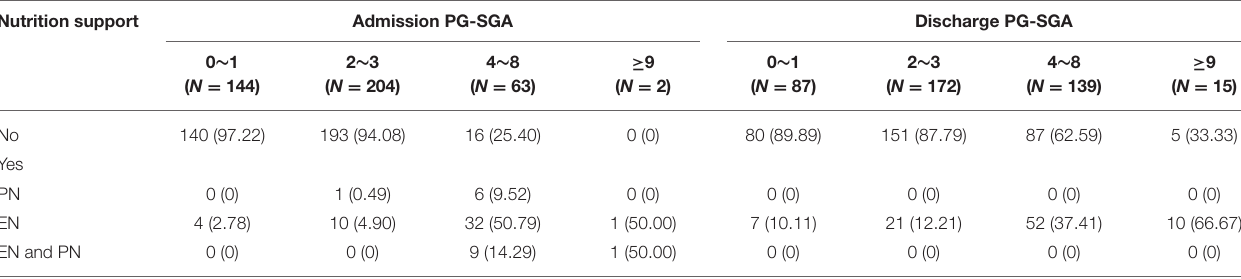
TABLE 2 | Patient-generated subjective global assessment classification and nutritional support situation [ n